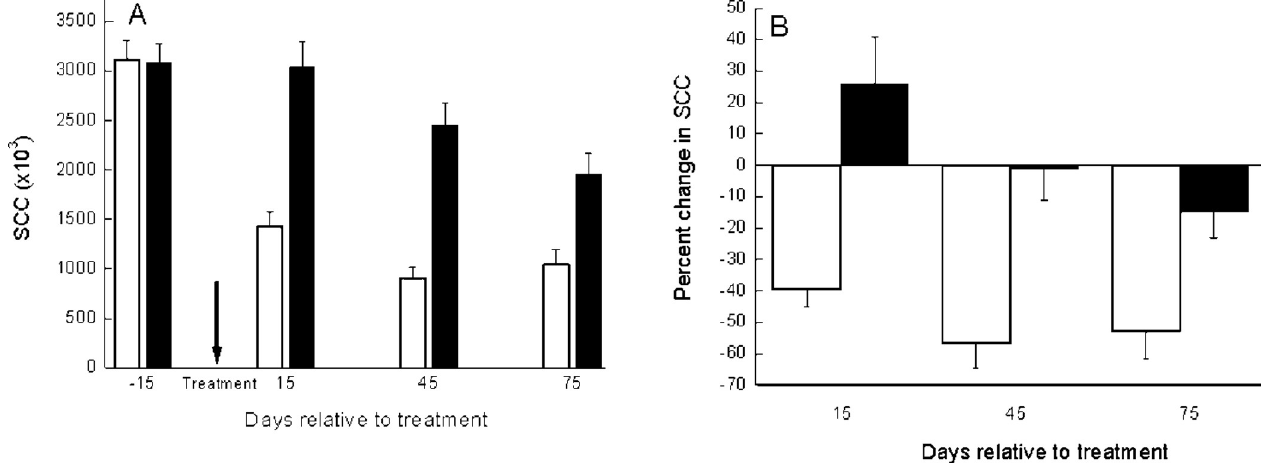
Fig 2. Mean and SE of somatic cell count. Mean and SE of somatic cell count (SCC × 10 3 ) ( 2A ) and the average percent individual change in SCC relative to time of treatment (t = 0) during the first 75 d post-treatment ( 2B ) of 103 APT ( □ ) and 103 untreated ( ■ ) cows with mastitis.